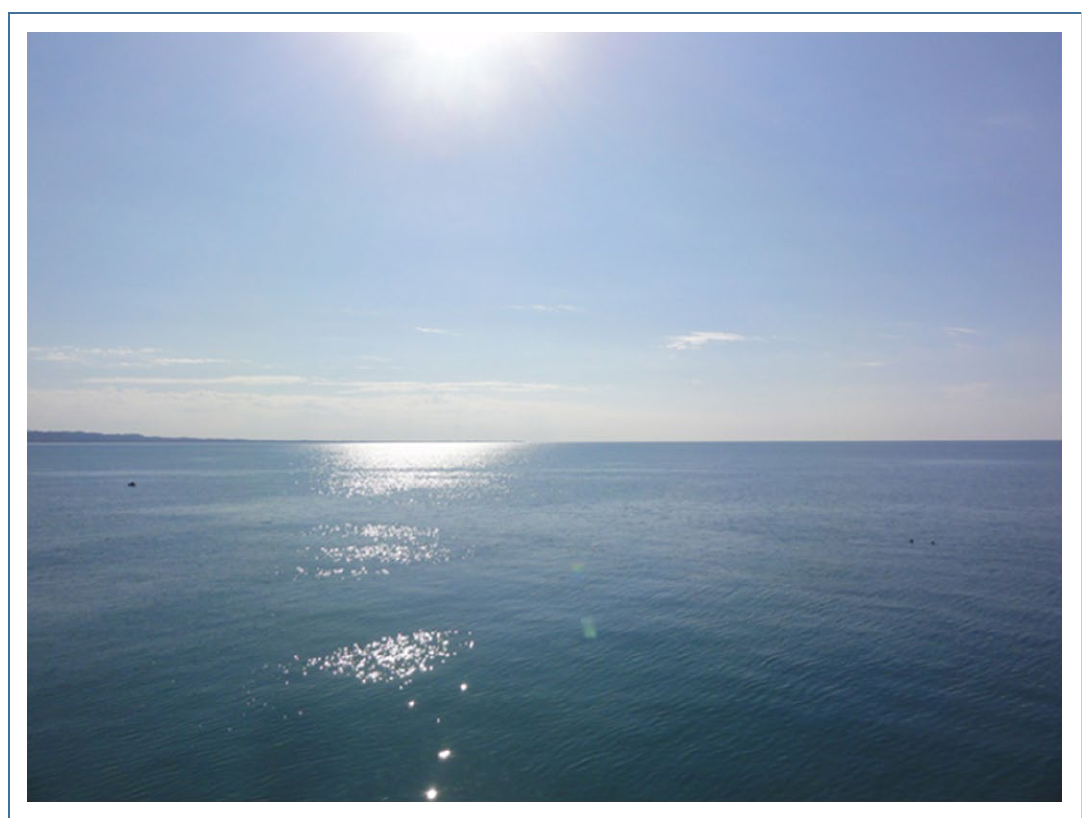
Figure 14. The photography of the sea surface taken on 4 October 2020 at 09:53 LT by E. Khimchenko towards Cape Kodor to the southeast of the platform. Slick bands associated with internal waves are visible in the sea at a distance of 2–3 km.